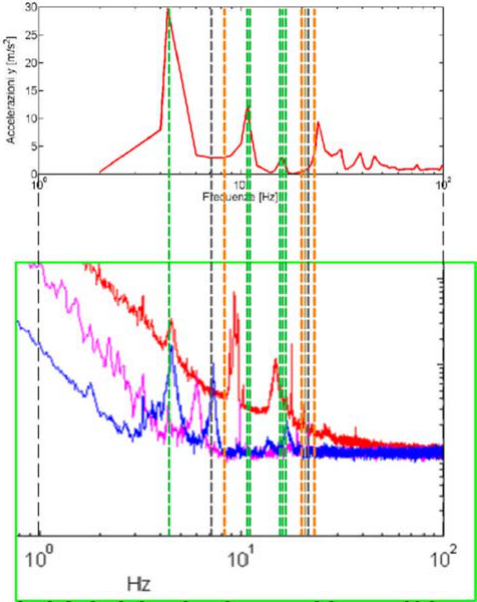
Figures 16. Amplification function comparison for longitudinal and transversal direction-central node